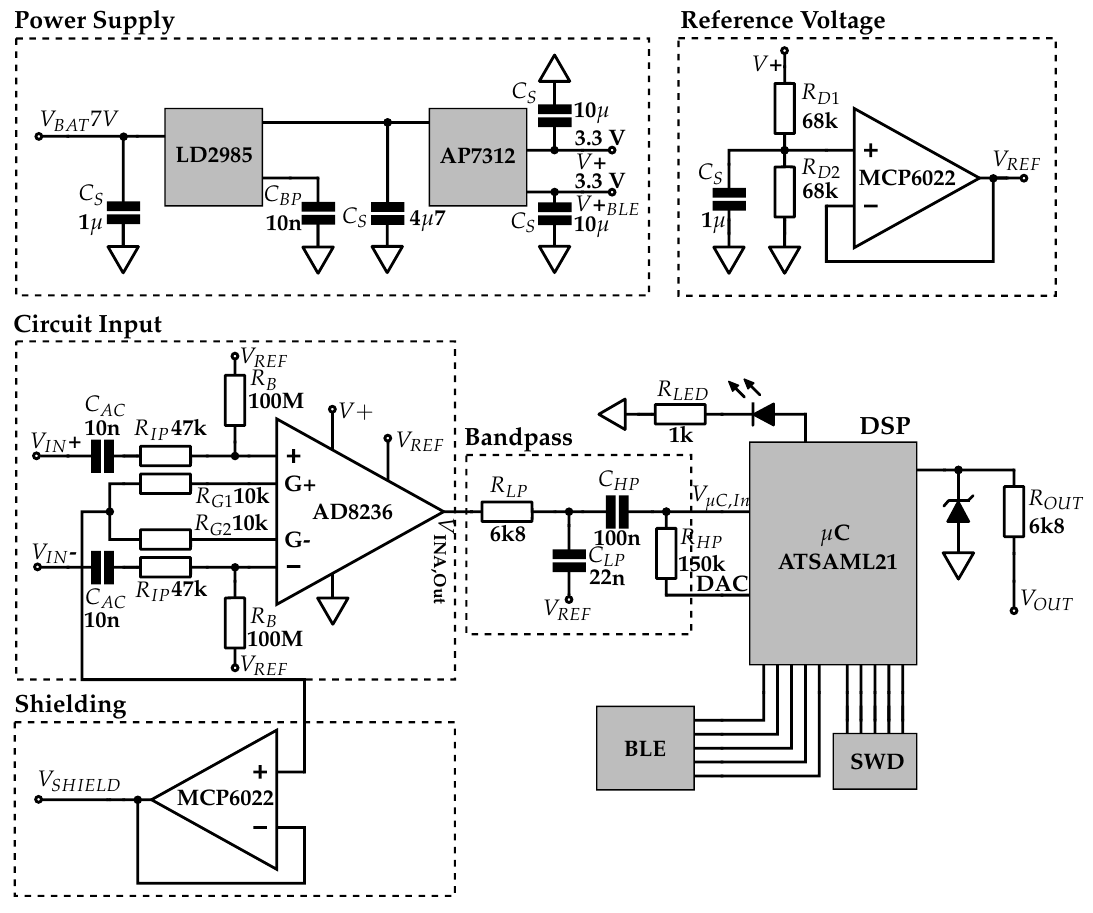
Figure 4. Circuit diagram of insulated EMG measurement